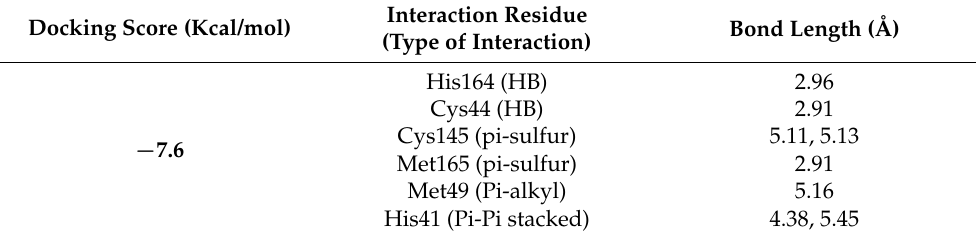
Figure 7. Proposed binding mode of 3b with COVID-19 main protease. Table 6. Docking study results of 3b with COVID-19 main protease.